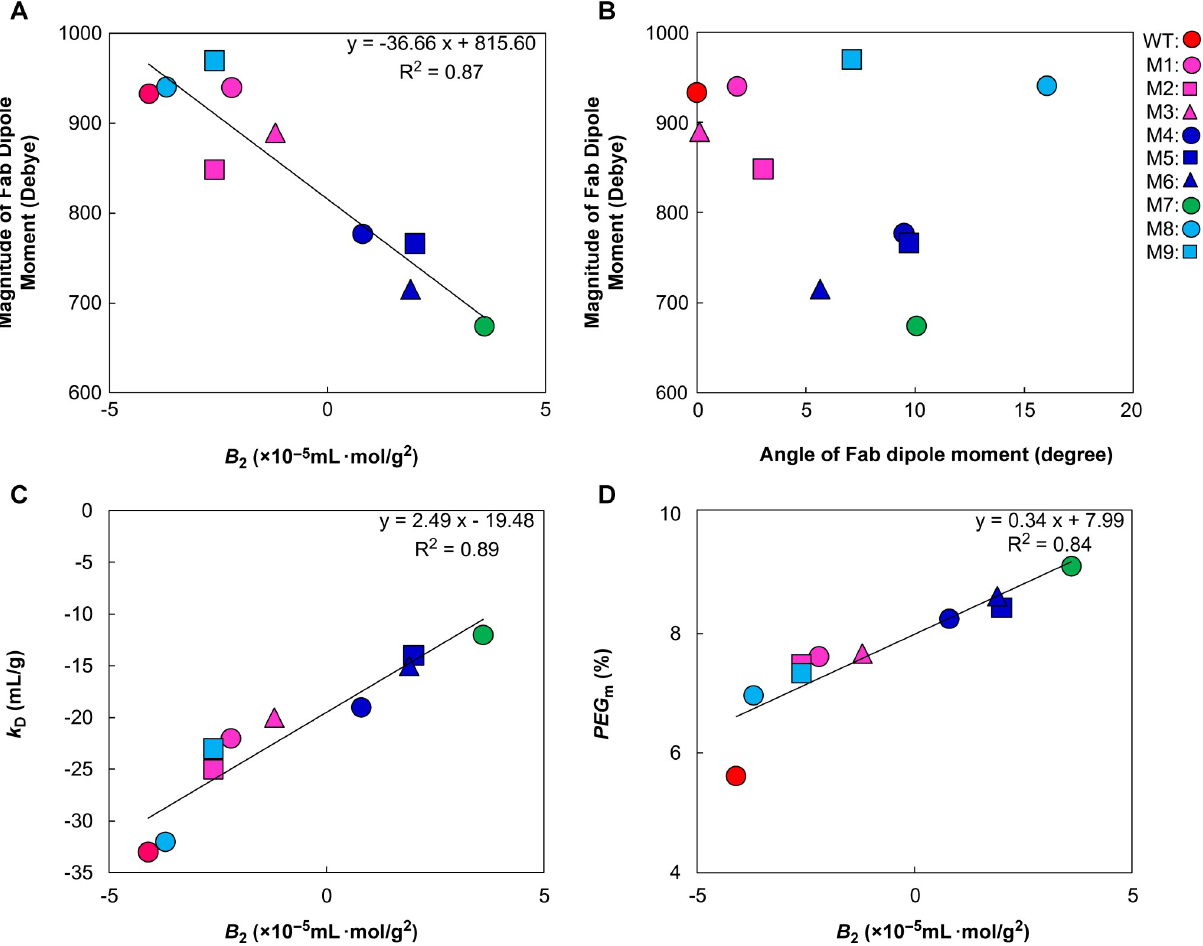
Fig 5. Correlations among various biophysical parameters of WT mAb1 and mutants in buffer A. (A) The magnitude of the Fab dipole moments was plotted against B 2 values; (B) The angle between the WT dipole moment and each mutant dipole moment was plotted against the magnitude of the Fab dipole moment; (C) The k D values were plotted against B 2 values; (D) The PEG m values were plotted against B 2 values. Least-squares linear regression lines, correlation equations, and correlational coefficients are shown in (A), (C), and (D).